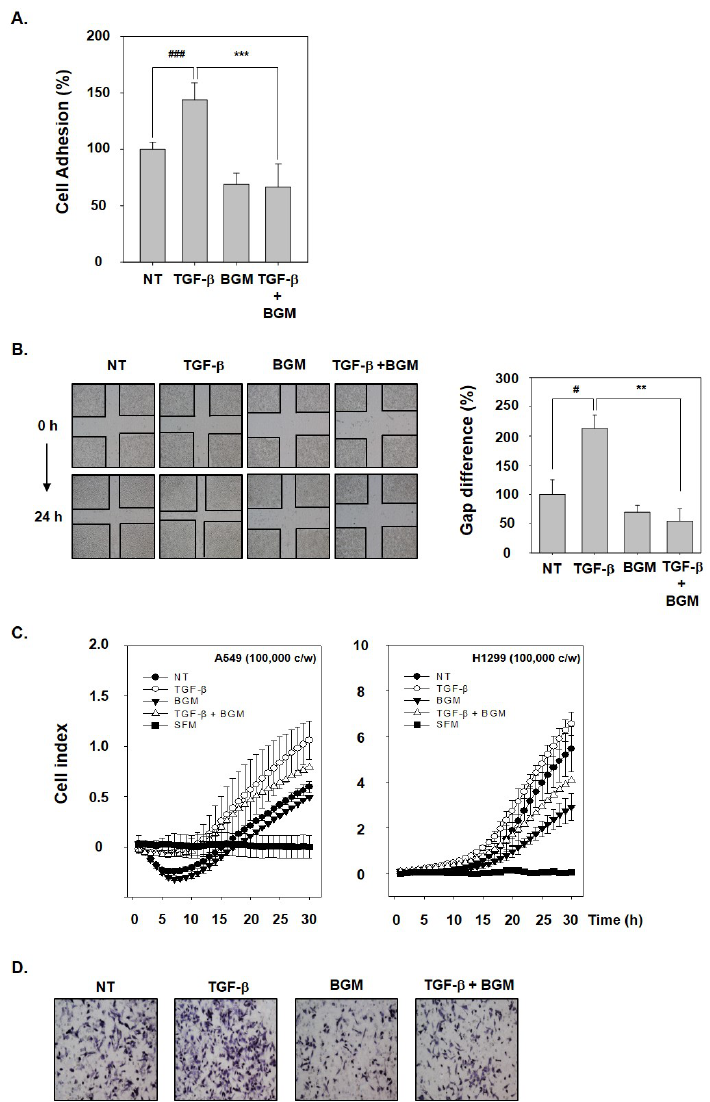
Figure 3. BGM inhibits invasion and migration of lung cancer cells. ( A ) Adhesion of A549 cells to collagen-coated plates with TGF- β (10 ng/ mL), BGM (100 μM), or the combination treatment for 40 min. The extent of cell adhesion was quantified by MTT assay. Values are mean ± SD. ### p < 0.001 vs. nontreated (NT) cells, *** p < 0.001 vs. TGF- β -treated cells. ( B ) To analyze migration, A549 cells were wounded using a sterile tip. The cells were treated as described above to determine the rate of migration. Values are mean ± SD. # p < 0.05 vs. NT cells, ** p < 0.01 vs. TGF- β -treated cells. ( C ) Invasion assay was performed with 100,000 cells/well from A549 and H1299 cells in CIM-plate 16 precoated with Matrigel. The rate of invasion was monitored in real-time using the xCELLigence system. ( D ) The anti-invasive effects on A549 cells were detected on the membrane staining with hematoxylin